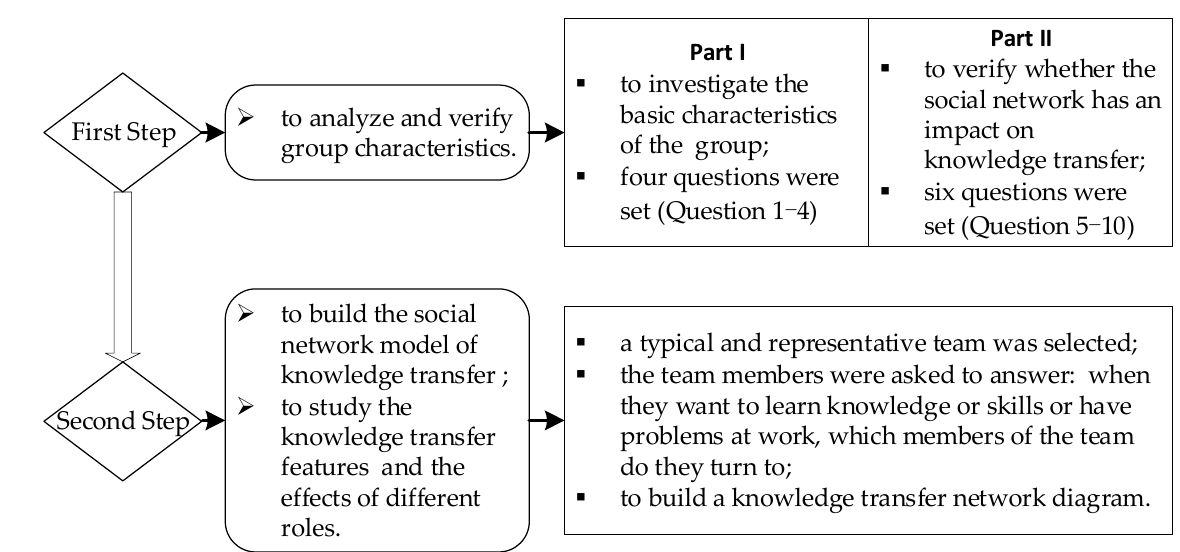
Figure 1. The flow chart of the research.